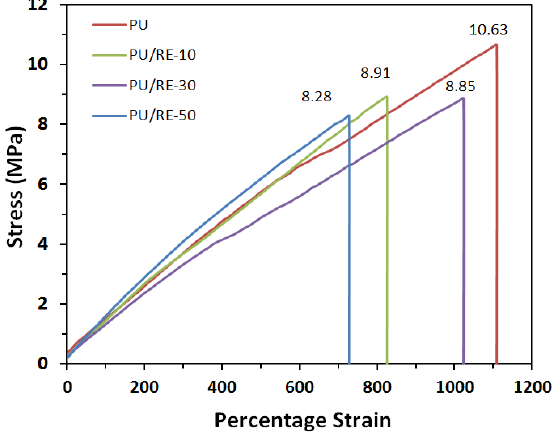
Figure 4. Tensile strength of electrospun PU mats with different amounts of RE.